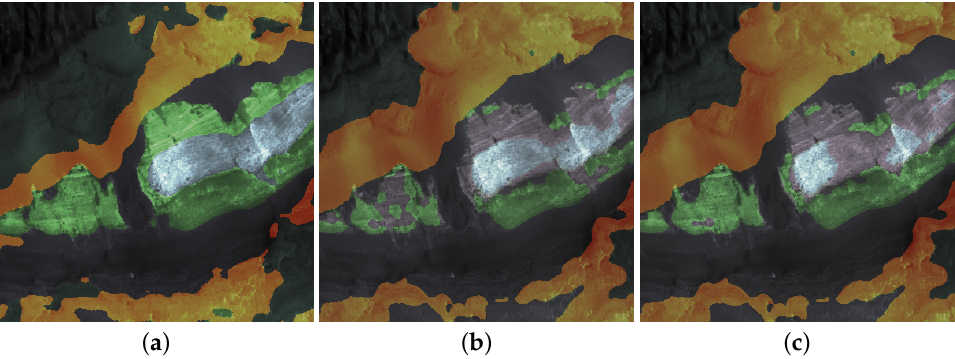
Figure 6. Spectral cluster maps generated for a configuration of six clusters and the FRT0001c71b dataset. In ( a ) Spectral cluster map, UMAP + K-Means is applied, in ( b ) Cluster map based on four selected summary products and in ( c ) Cluster map based on CaSSIS bands.